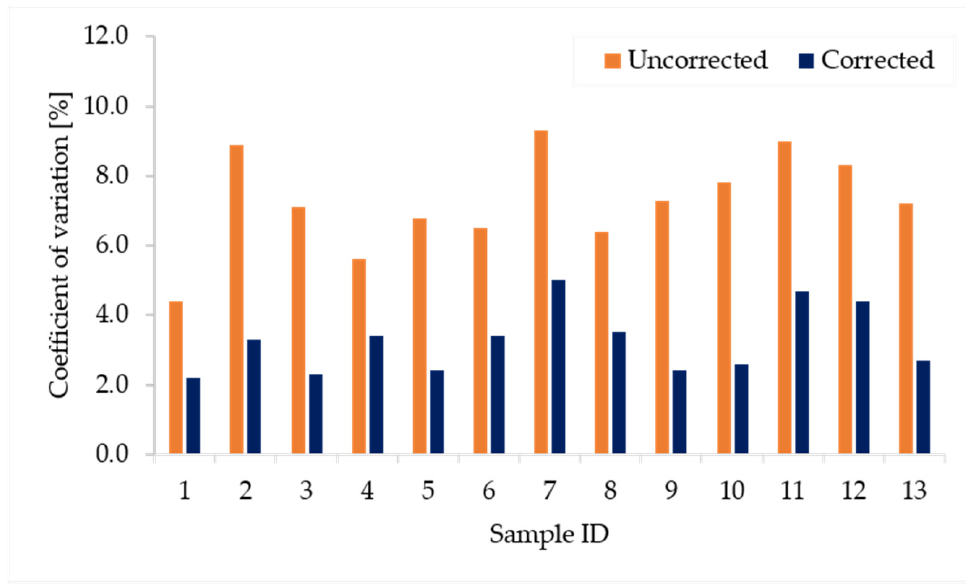
Figure 12. Coefficients of variation between HVIs for a span length of the 60% SL over 13 USDA commercial samples before and after correction.